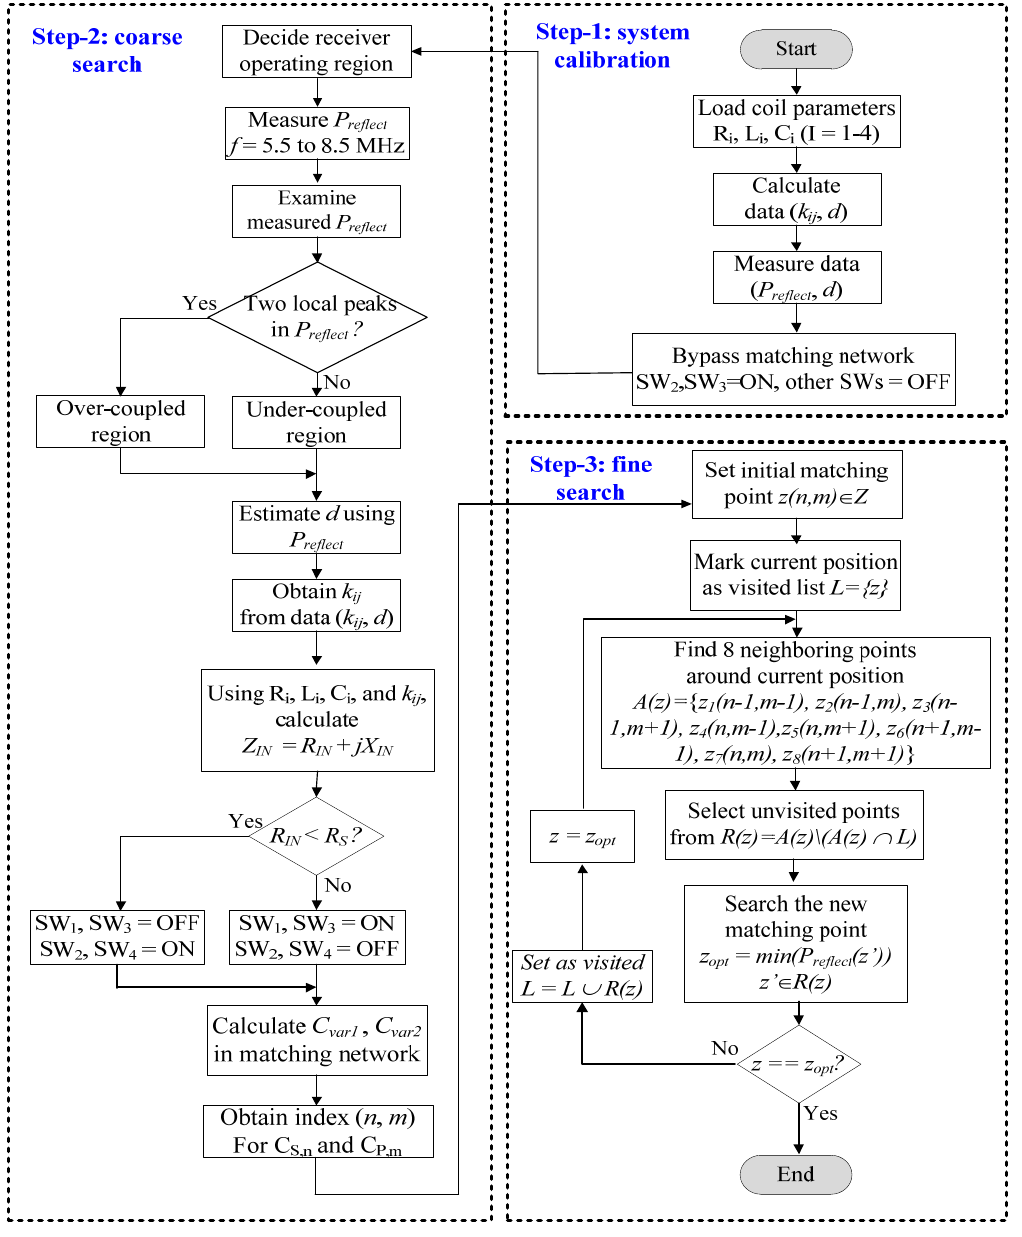
Figure 6. Flow chart showing the impedance searching